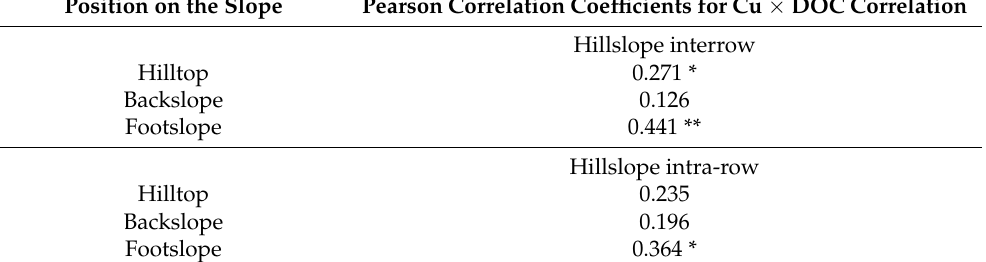
Table 3. Correlations between copper and dissolved organic carbon concentrations in leachates collected monthly for two years (2 November 2020–25 November 2022) from lysimeters installed at the hilltop, backslope and footslope of the vineyard inter- and intra-row.